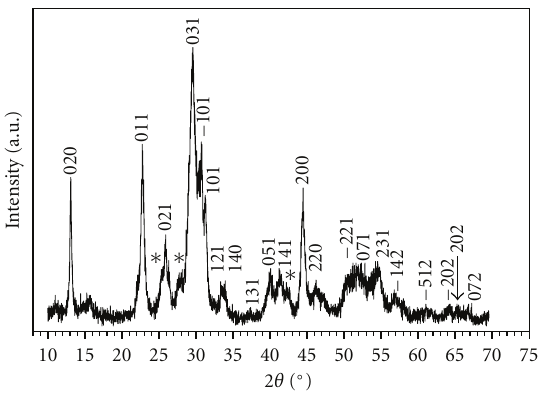
Figure 3: X-ray di ff raction pattern of La 2 O 2 CO 3 (monoclinic) obtained by heating La 2 O 3 at 520 ◦ C under CO 2 flow. Trace of hexagonal phase (noted ∗ ).